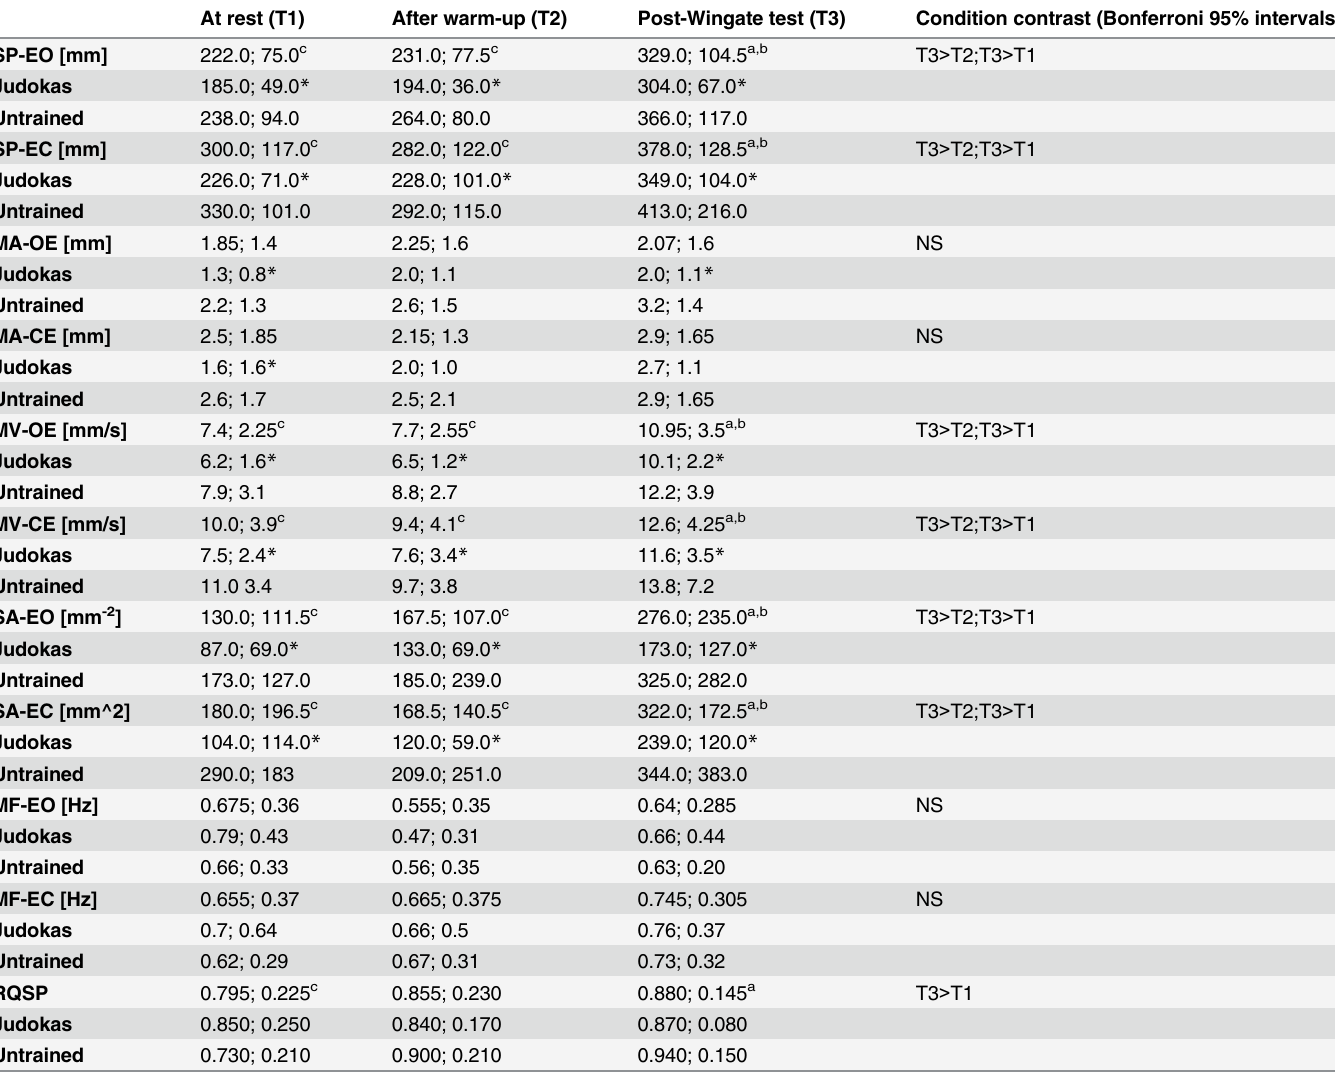
Table 6. Balance indices for judokas and university students with eyes open and eyes closed (Median; IQR interquartile range). At rest (T1) After warm-up (T2) Post-Wingate test